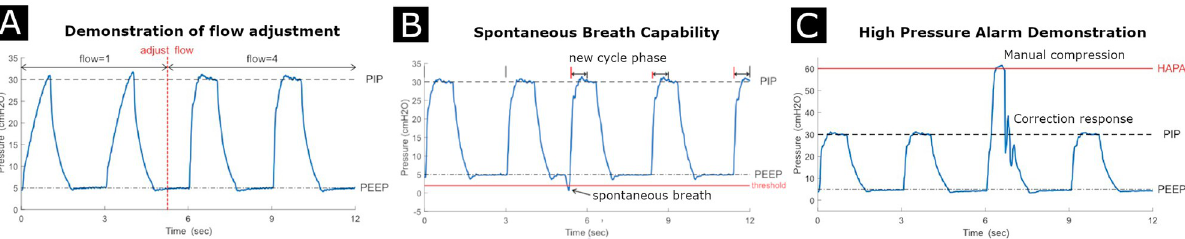
Fig 3. Demonstration of waveform tuning and system capabilities. A Demonstration of flow adjustment. If necessary, the operator can increase the flow setting through the system GUI to decrease the pressure ramp time. B Demonstration of a phase-shift if spontaneous breath is detected. C Demonstration of the response to a rapid high pressure transient. Test settings in all three cases: compliance C = 20 mL/cmH 2 O, airway resistance R = 20 cmH